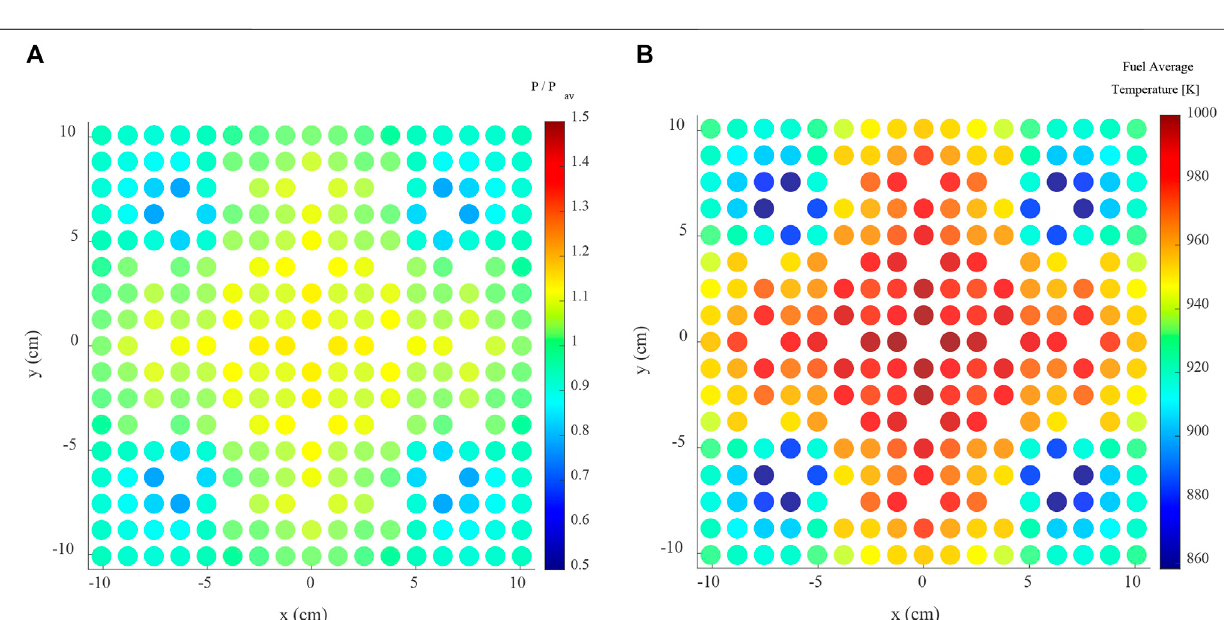
Frontiers in Energy Research |